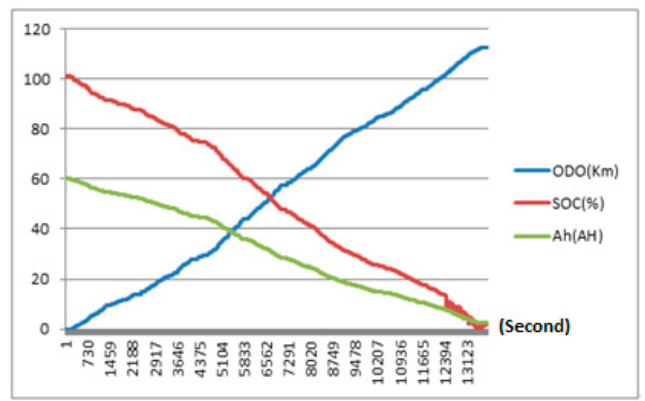
Figure 13. Histories of accumulated mileages, SOC and accumulated Ah.